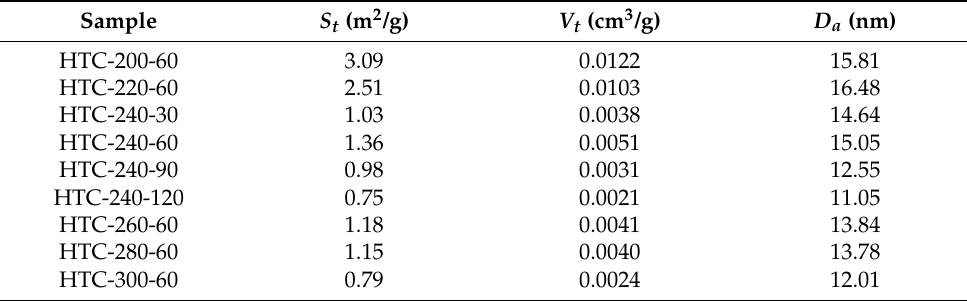
Table 2. Pore structure parameters of hydrochar under different hydrothermal